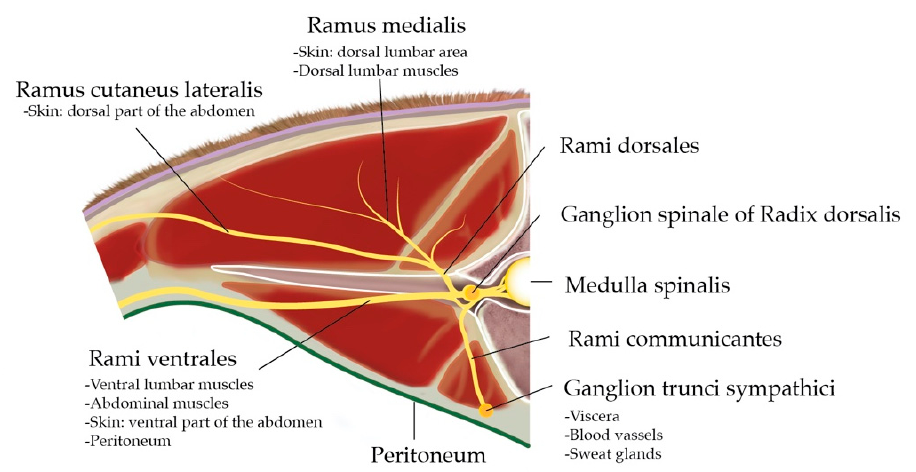
Figure 2. Cranial view at the intervertebral junction L1–L2: anatomical organisation of the spinal nerve L1 and area of innervation of the different Rami. Credits to C.A.R.